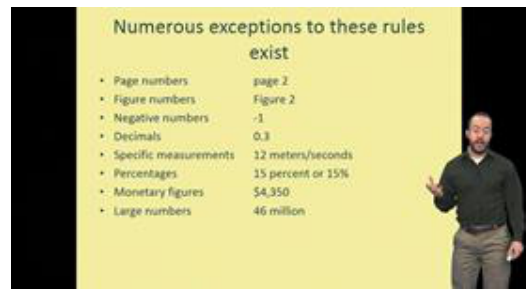
Figure 1 . Main video lecture without summaries.